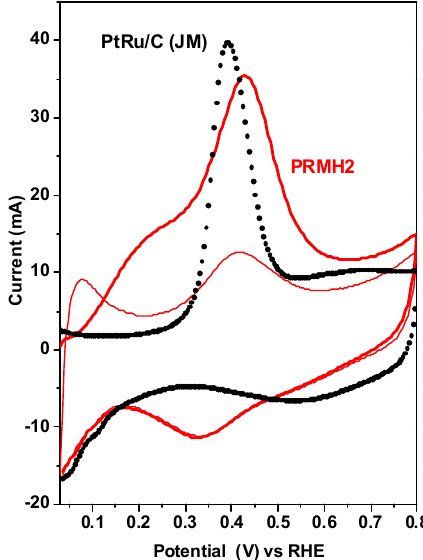
Figure 7. CV of the CO oxidation for PRMH2 and commercial catalyst PtRu/C (JM). ads Experiment performed in a half cell single cell at 75 °C. The continuous line is the first two cycles of the CO oxidation of PRMH2, and the dotted line is the first cyclic voltammetry ads of the CO oxidation of the PtRu/C (JM). Adapted from Tsiouvaras et al. [45]. ads